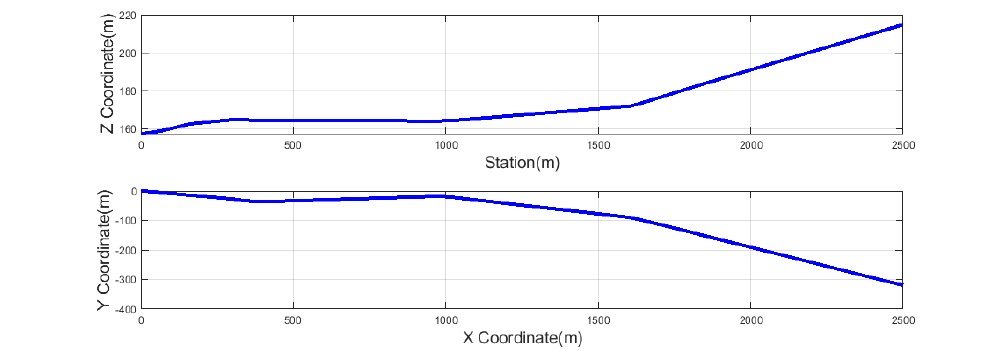
Figure 9. Simulation